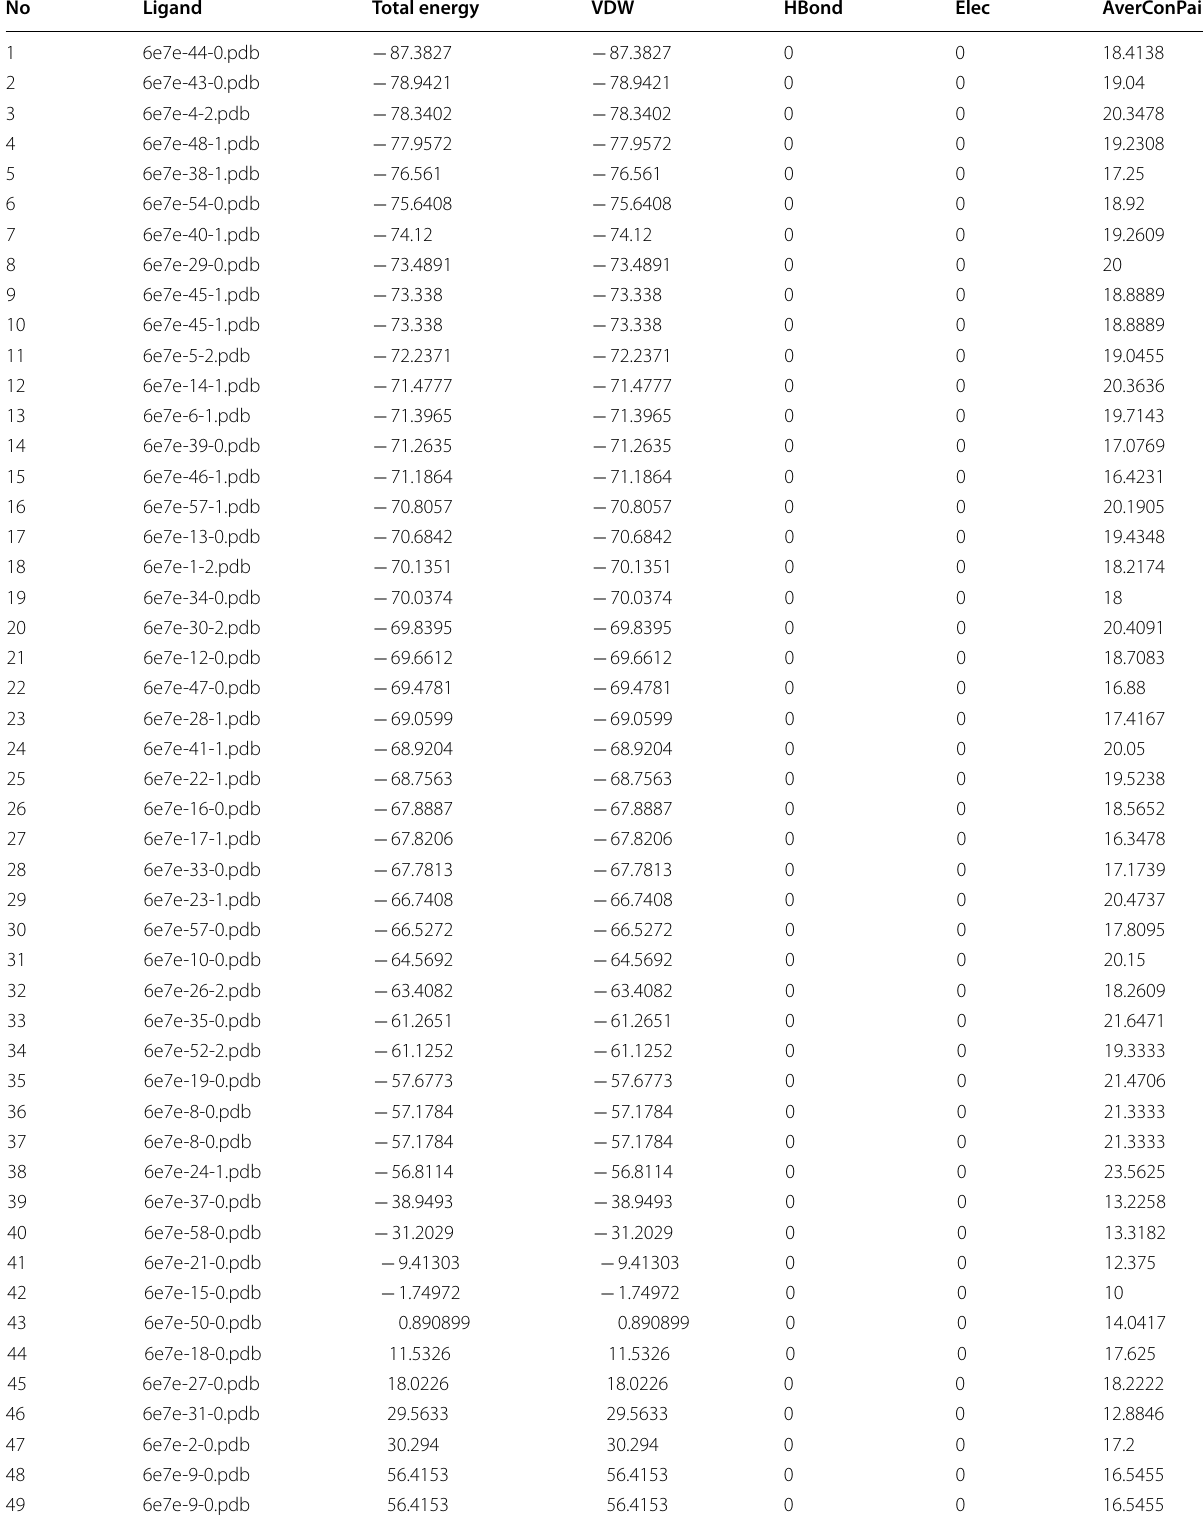
Table 3 The results of the 58 salicylidene acylhydrazides derivatives with iGemDock v2.1